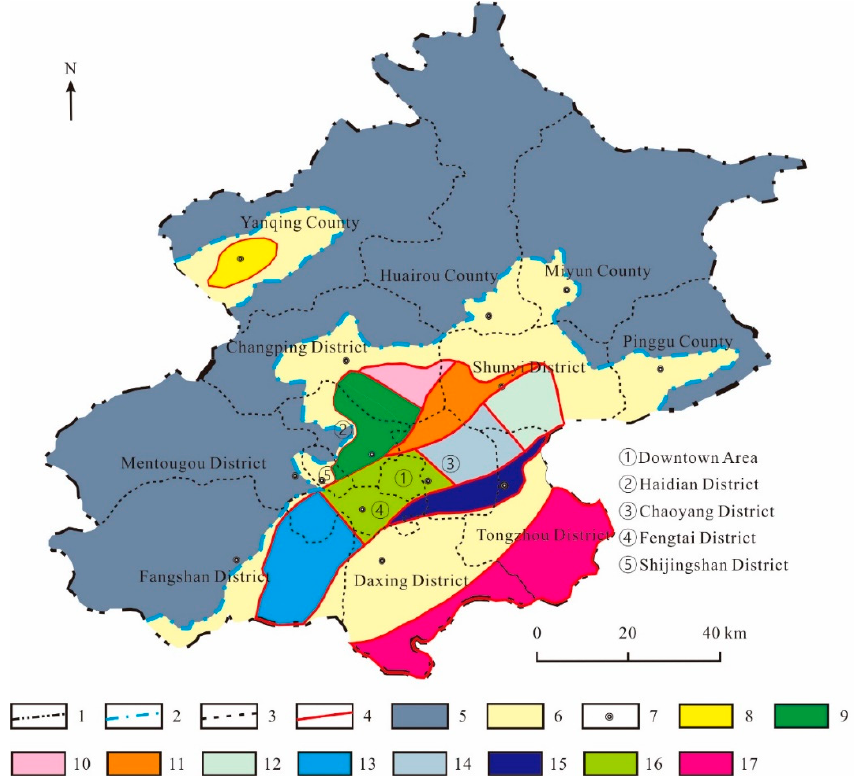
Figure 6. Location of the subgeothermal fields in Beijing. 1—Administrative boundary of Beijing; 2—Boundary between mountainous area and plain area in Beijing; 3— Boundary of each county in Beijing; 4—Boundary of each subgeothermal field; 5—Mountainous area; 6—Plain area; 7—